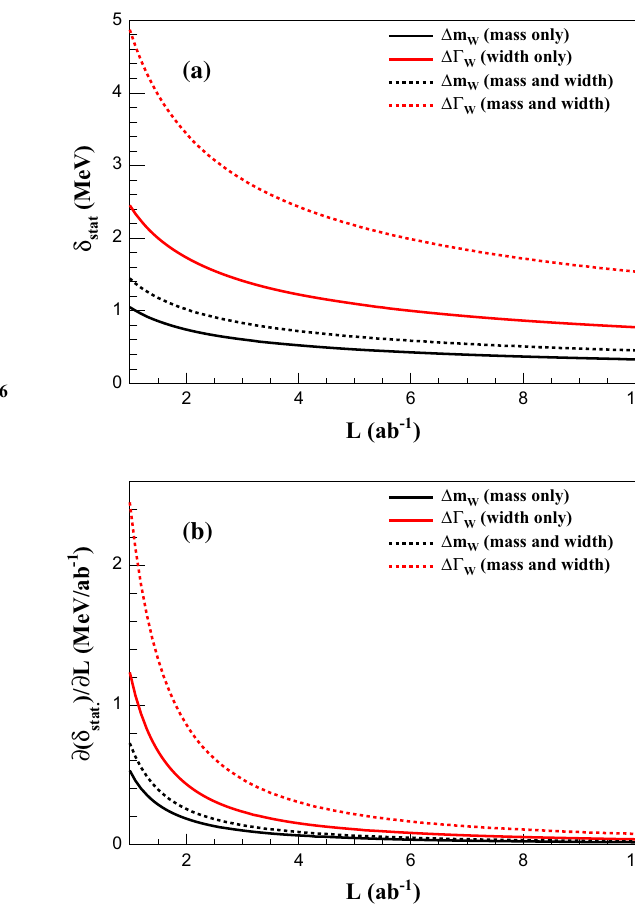
Fig. 4 Distributions of the statistical uncertainties of m W (a) and Γ W (b) for taking data at a single energy point